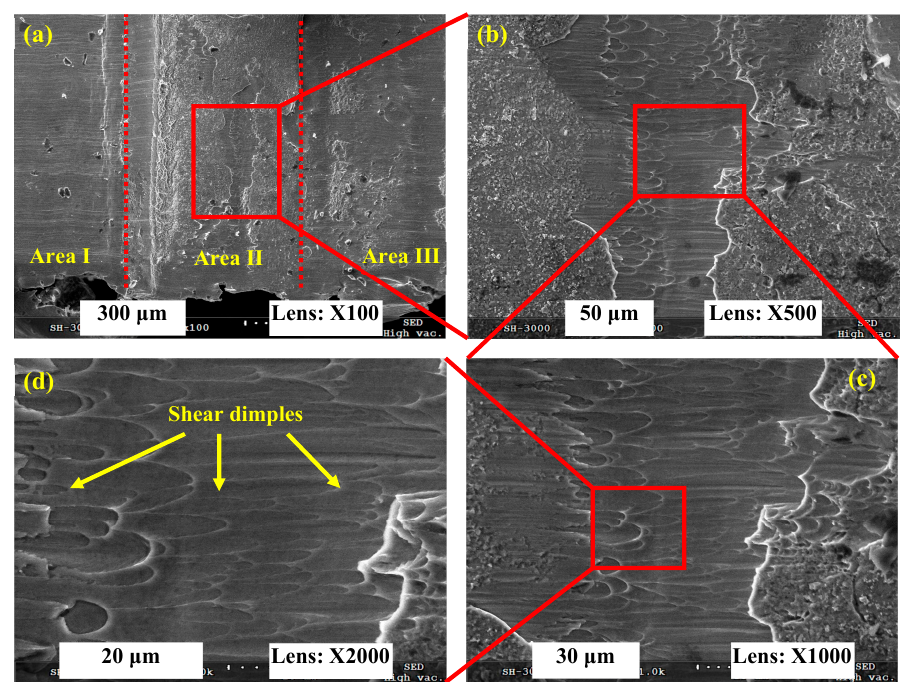
Figure 8. SEM micrographs of a chip root for Inconel 718 produced under V = 6000 m/min. ( a ) macroscopic morphology of chip root; ( b – d ) indicate microscopic morphologies of magnified areas shown in ( a – c ).